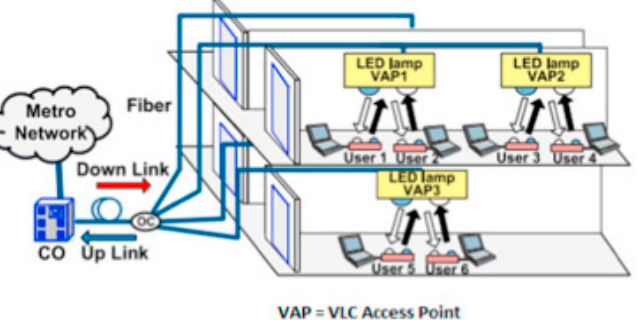
Figure 19. VLC using in wireless local area networks. Figure reused from [5] under a Creative Commons Attribution Non-commercial Non-Derivative 4.0 International license (CC BY-NC-ND 4.0).